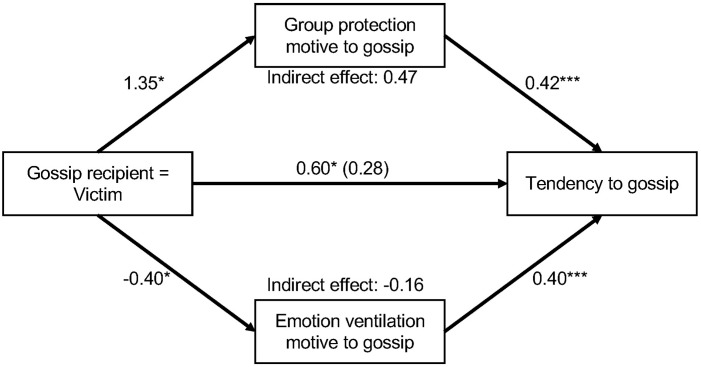
Unstandardized regression coefficients for the relationship between victim condition (victim versus non-victim) and tendency to gossip as mediated by group protection and emotion venting motives. The other motives have been omitted for clarity. The regression coefficient between victim condition and tendency to gossip, controlling for all other motives is in parentheses. Victim condition is dummy-coded (1 = victim, 0 = non-victim). *p < 0.05, ∗∗∗p < 0.001.